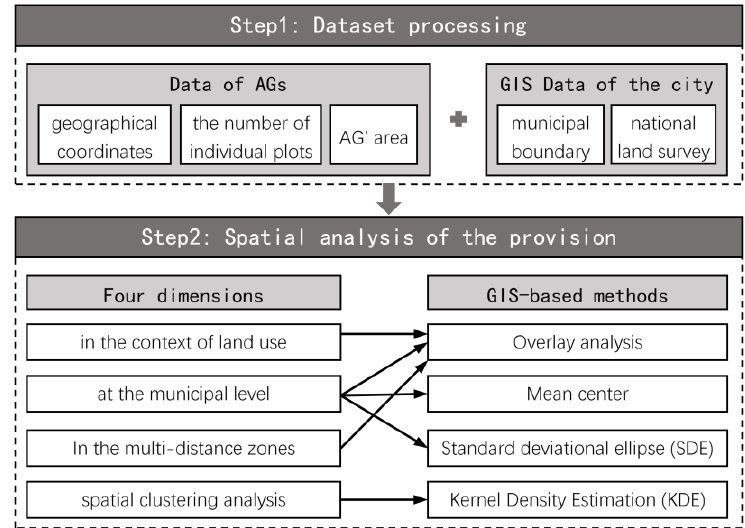
Figure 3. Graphical overview of the GIS methods presented.